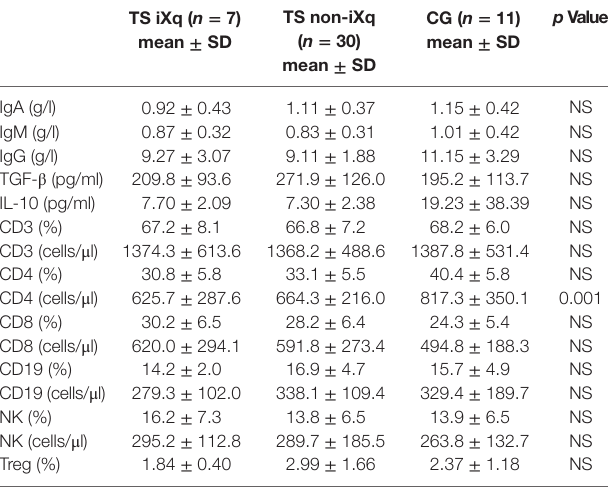
Table 3 | Laboratory markers of humoral and cellular immunity, and anti- inflammatory cytokines in girls with TS and the iXq karyotype vs. girls with TS non-iXq and vs. healthy controls (mean ±